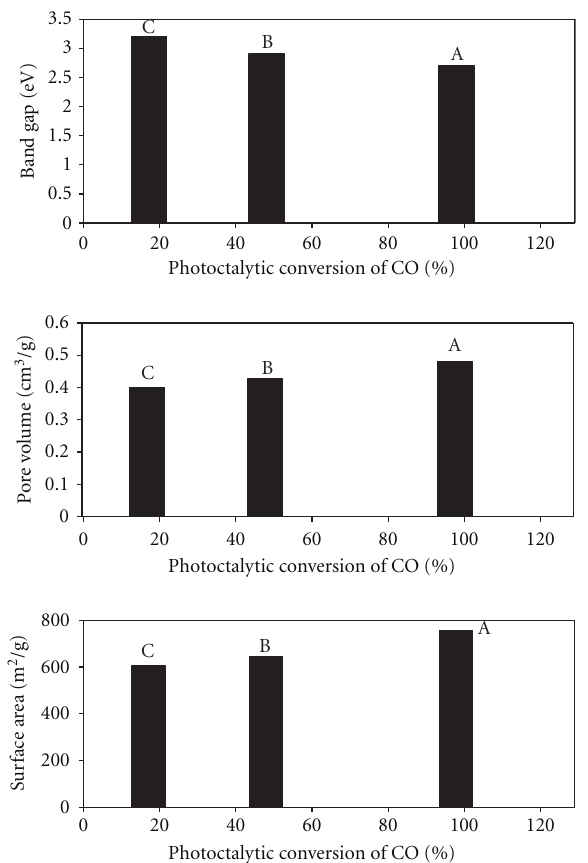
Figure 8: E ff ect of physical parameters of the materials on their photocatalytic activity for PAD-Au/Ti-HMS (A), img-Au/Ti-HMS (B) and Ti-HMS